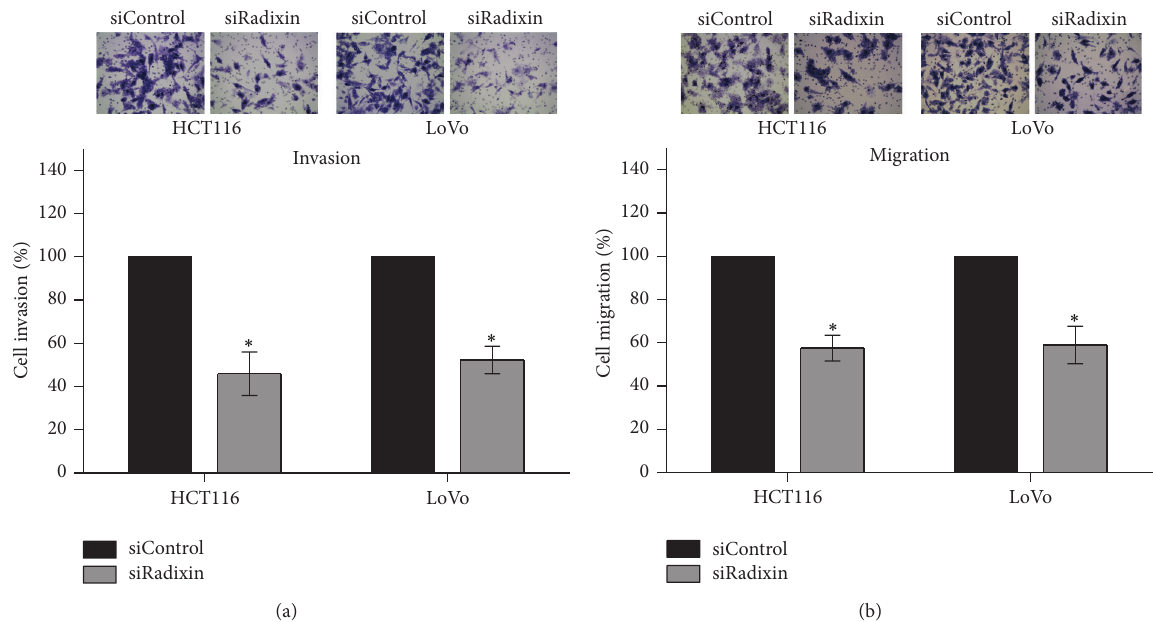
Figure 3: Knockdown of radixin by siRNA suppressed the invasion and migration of colon cancer cells. After transfection with radixin siRNA or control siRNA, cells were subjected to invasion and migration assays. (a) Effect of radixin knockdown on the invasion of HCT116 and LoVo cells. (b) Effect of radixin knockdown on the migration of HCT116 and LoVo cells. ∗ 𝑃 < 0.05